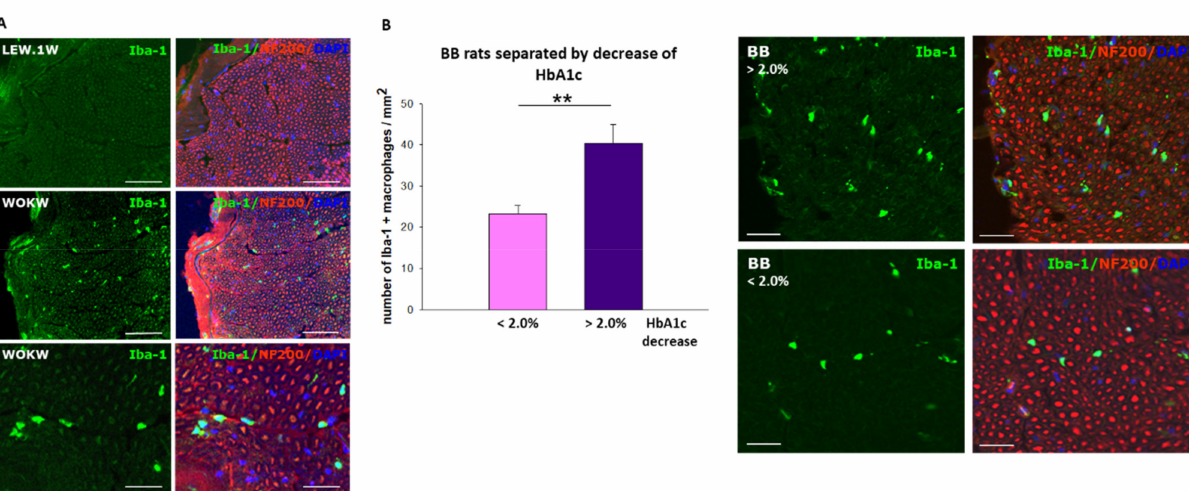
Figure 1. ( A ): Macrophages distribution in sciatic nerves of WOKW rats with metabolic syndrome and health LEW.1W control rats; [21]. Double immunofluorescence staining for Iba-1 (green, macrophages) and for neurofilament 200 (red). Nuclei are counterstained with DAPI (blue). Bar represents 100 µ m and 50 µ m (lower panel). ( B ): Macrophage distribution in sciatic nerves of BB/OKL rats stratified by the reduction in HbA1c values at the end of month 3 of insulin application [22]. Diagram: Quantification of Iba-1 (ionized calcium binding adaptor molecule 1)—positive macrophages. Photomicrograph: Double IF staining for Iba-1 (green, macrophages) and for neurofilament 200 (red). Note that the greater number of macrophages in sciatic nerve correlated with a larger reduction in HbA1c values (>2 per cent steps) as compared with